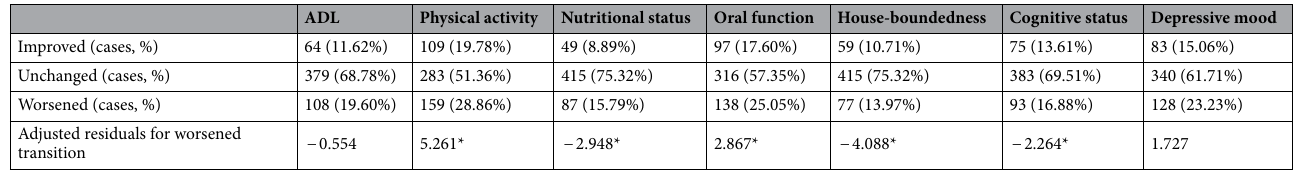
ADL Physical activity Nutritional status Oral function House-boundedness Cognitive status Depressive mood